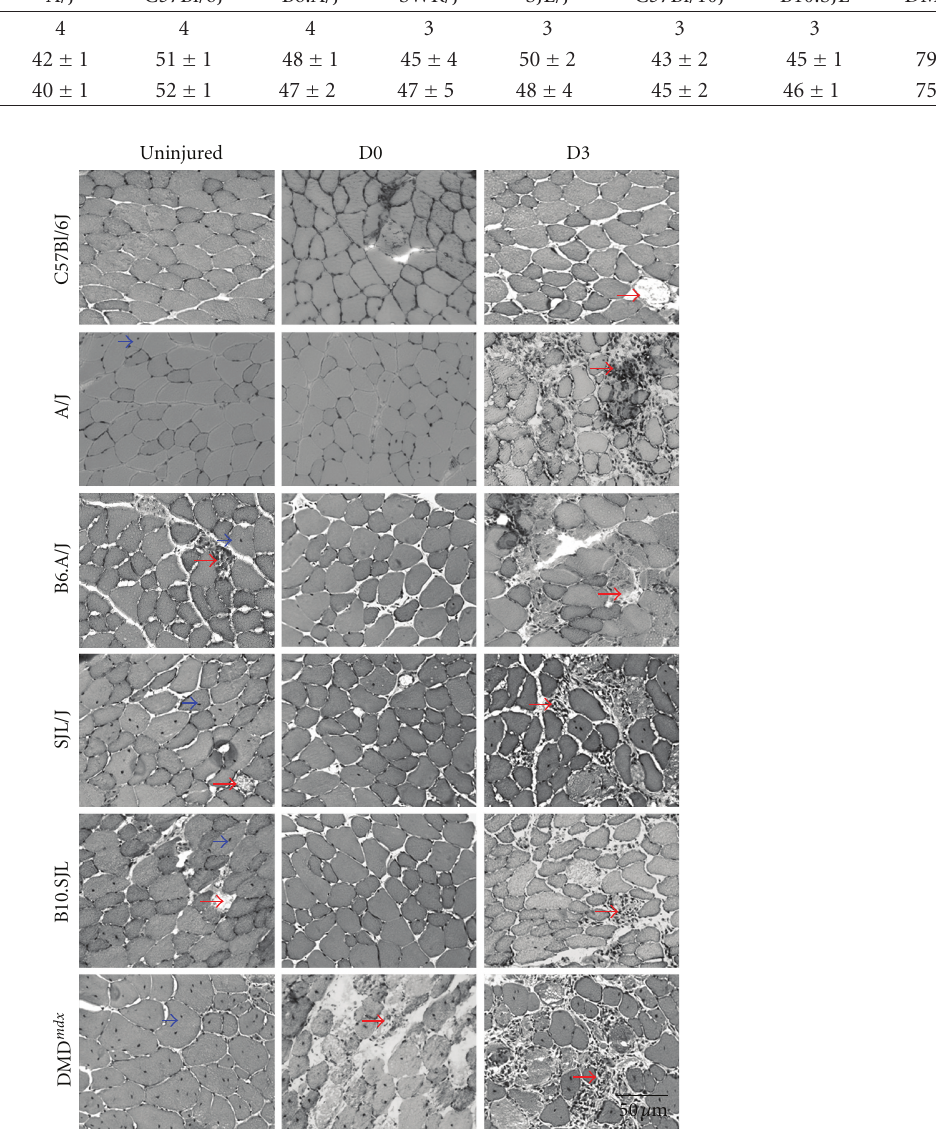
Figure 3: Histology before and after injury. We labeled TA muscles with H&E stains. In uninjured muscle, necrotic fibers identified by pale, disrupted cytoplasmic staining and infiltrated by mononuclear cells appeared in all dysferlinopathic strains except A/J (red arrows). All dysferlin mutants had many CNFs (blue arrow heads) before LSI. At D3 post-LSI, necrotic fibers increased in all mutants, with the most widespread area of necrosis in A/J muscle. Extensive myofiber damage soon after LSI was visible in DMD mdx muscle, but not in control or dysferlinopathic